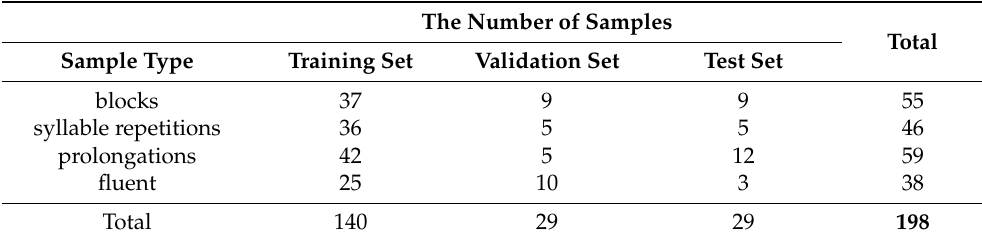
Table 2. Data distribution according to the disfluency type and affiliation to the training set. The Number of Samples Total Sample Type Training Set Validation Set Test